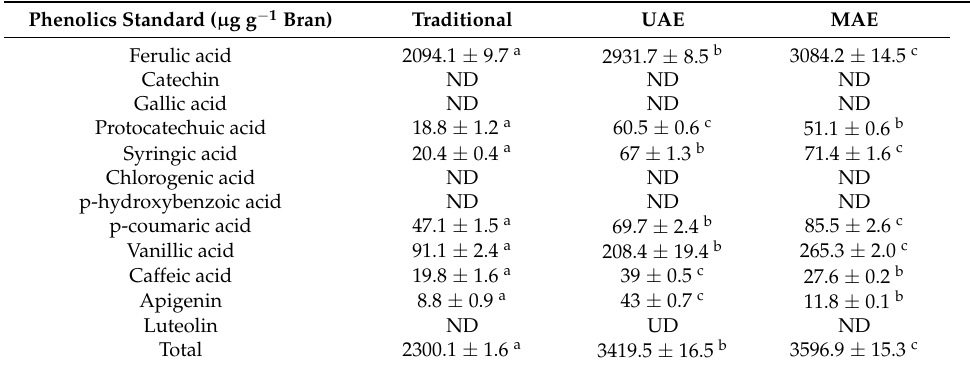
Figure 4. HPLC chromatogram of mixed standards and bound phenolic extracts obtained via different methods. Peak 1: gallic acid; peak 2: protocatechuic acid; peak 3: p-hydroxybenzoic acid; peak 4: catechin; peak 5: Chlorogenic acid; peak 6: vanillic acid; peak 7: caffeic acid; peak 8: syringic acid; peak 9: p-coumaric acid; peak 10: ferulic acid; peak 11: luteolin; peak 12: apigenin. Table 7. Phenolics composition of extracts from different methods.